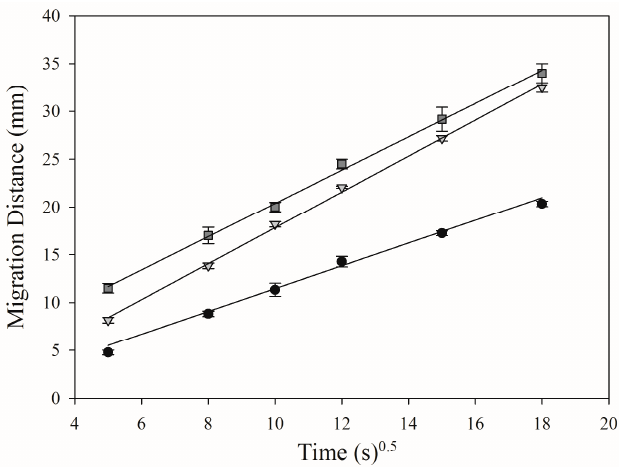
Figure 2. Comparison of mean mobile phase velocities with standard deviation (SD, n = 3) on HPTLC foil silica gel 60 ( ), HPTLC plate silica gel CN ( ) and electrospun PAN nanofiber phase ( ).